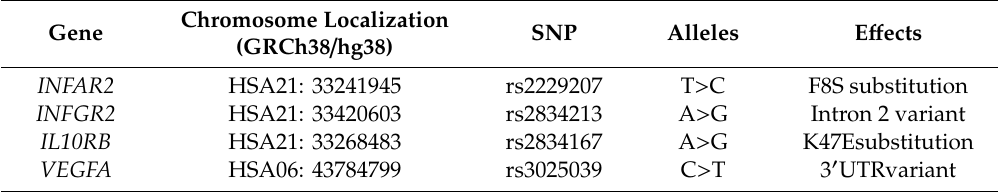
Table 2. Genes and single nucleotide polymorphisms (SNPs) (accession number) investigated in the study. Chromosome Localization Gene SNP Alleles E ff (GRCh38 / hg38)